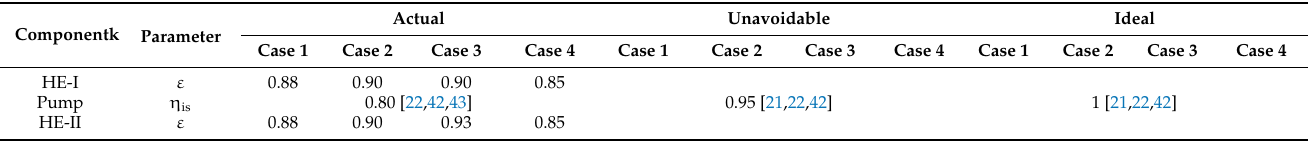
Table 3. Actual, unavoidable, and ideal conditions of components in the WH source DH system based on created cases. Componentk